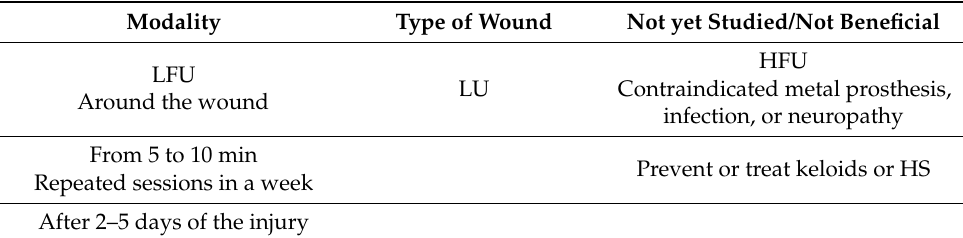
HFU LU Contraindicated metal prosthesis, infection, or neuropathy Prevent or treat keloids or HS